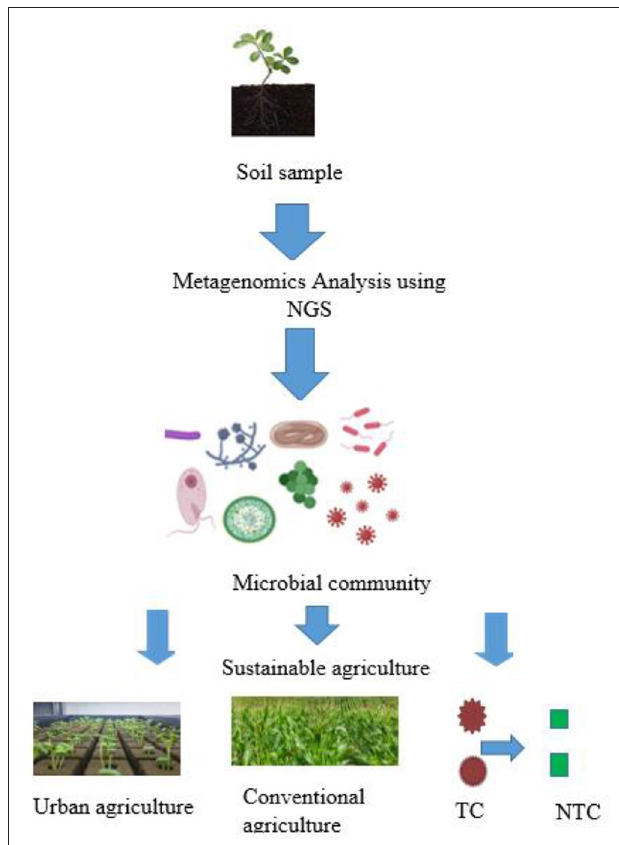
FIGURE 2 | Soil microbial genetic diversity and their applications in sustainable agriculture. Microbes obtained and identified from rhizosphere soil can be harnessed to enhance plant growth and productivity in both urban and conventional agriculture. Some of such microbes may also play a role in converting toxic contaminants to their respective non-toxic forms. NGS, next generation sequencing; TC, toxic contaminants; NTC, non-toxic